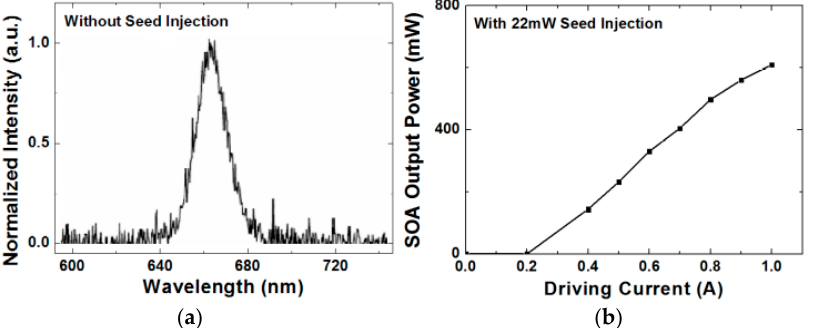
Figure 5. Gain spectrum without seed injection: ( a ) and P-I with seed injection; ( b ) of the 670 nm semi-conductor optical amplifier (SOA).